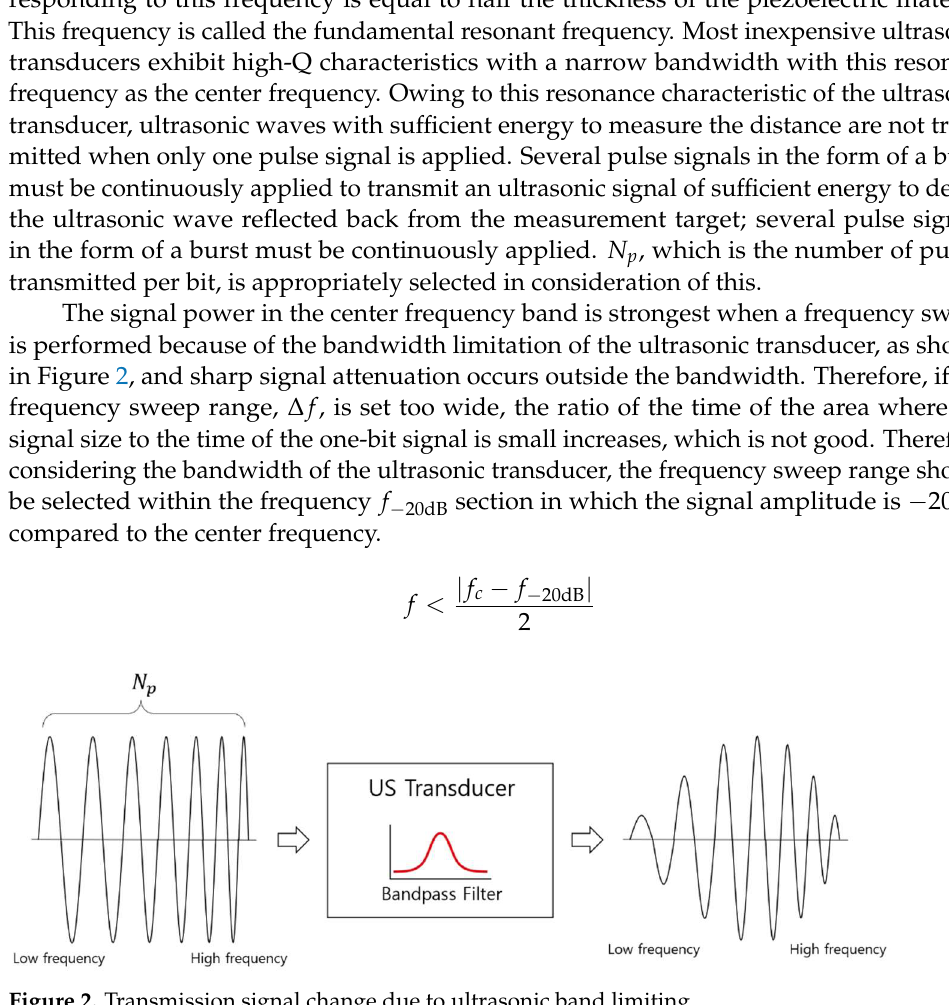
Figure 2. Transmission signal change due to ultrasonic band limiting.